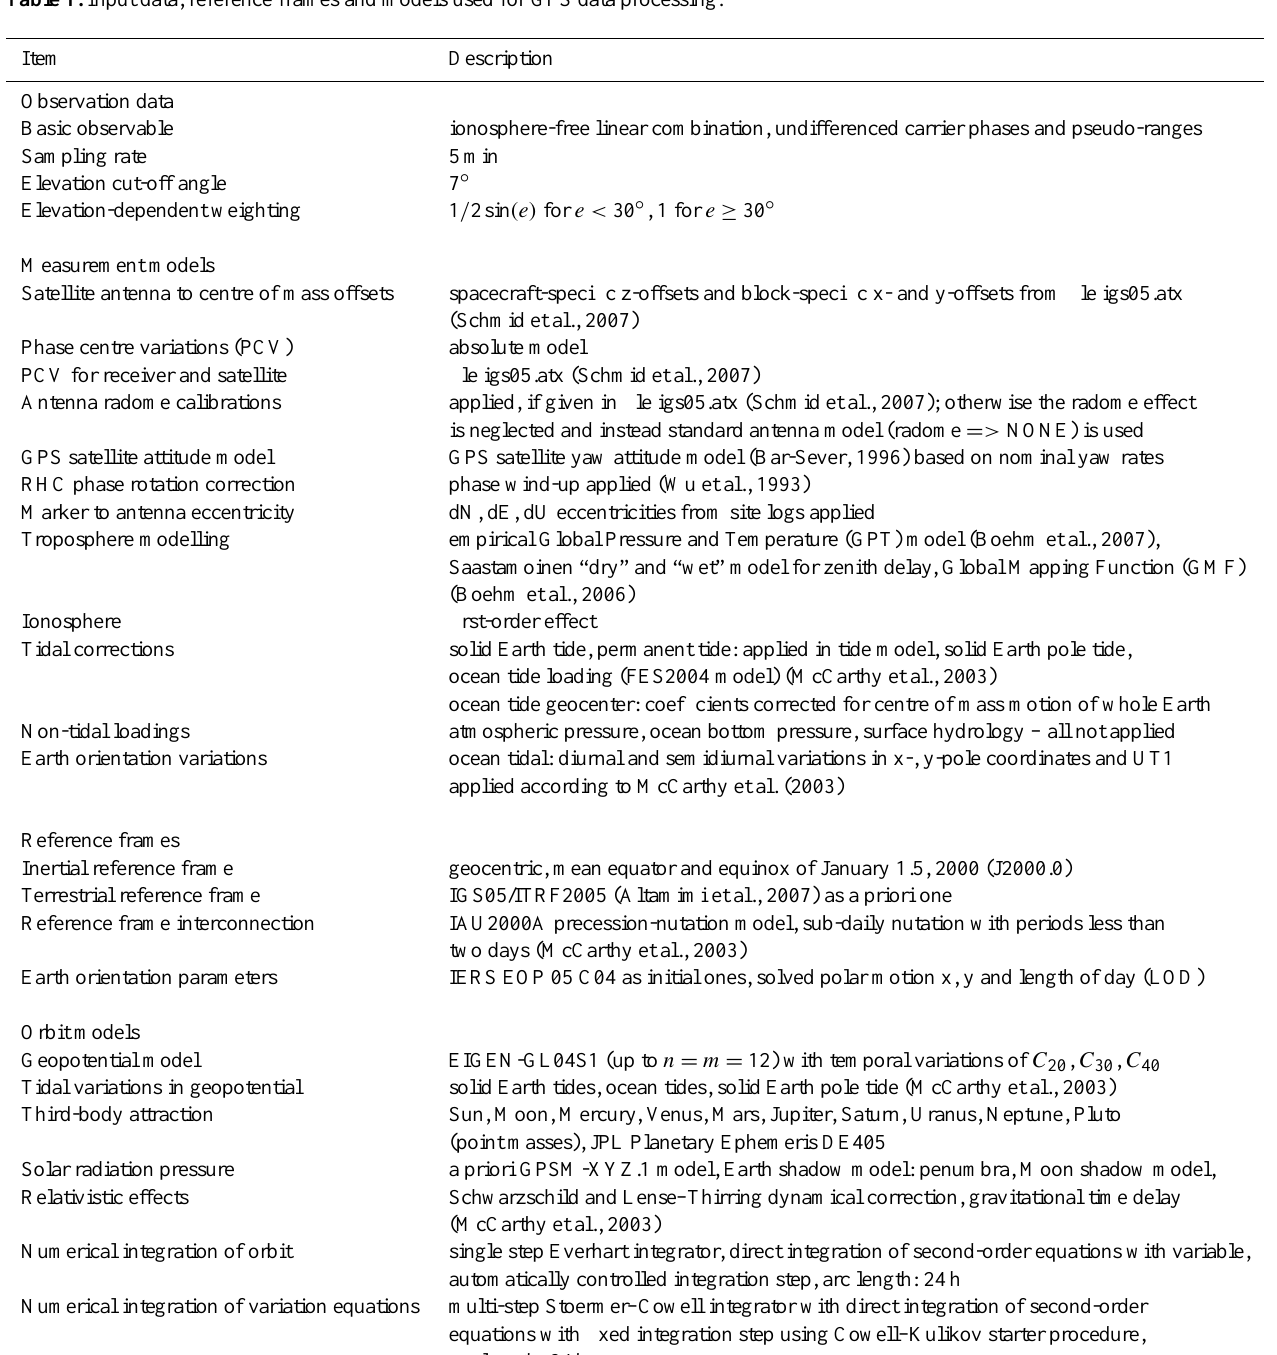
Table 1. Input data, reference frames and models used for GPS data